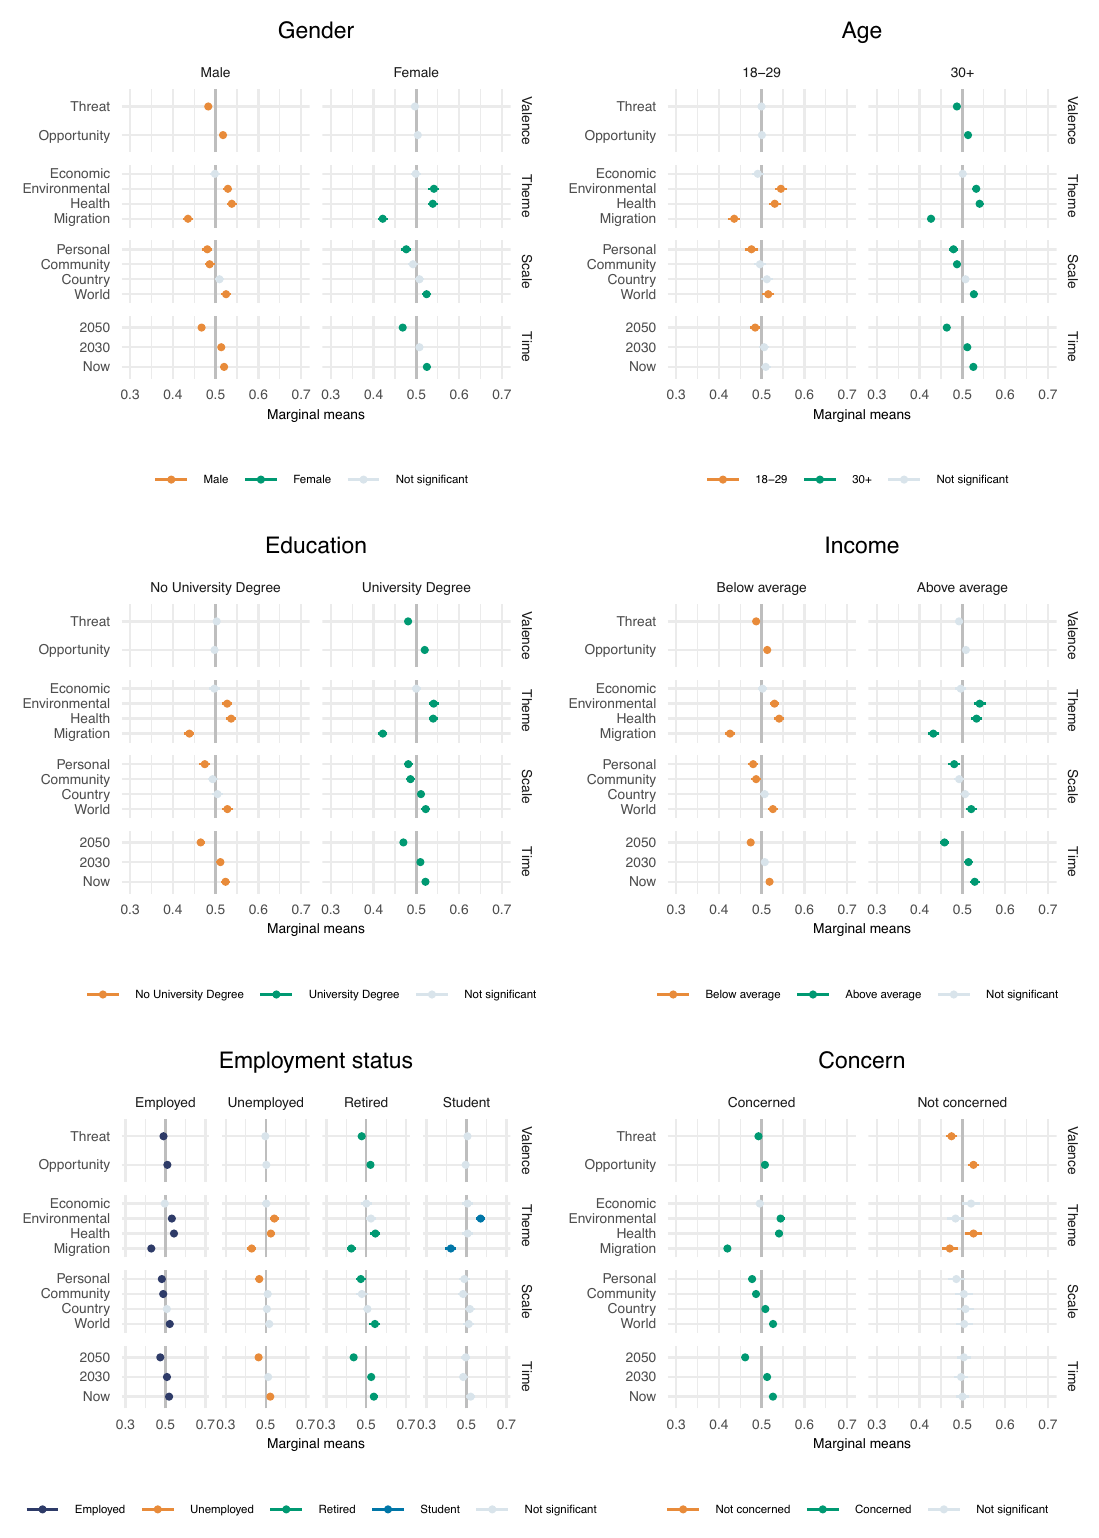
Fig. 2 Pooled results of the effects of different climate frames on support for climate policies across subgroups of respondents. Sample size n = 7512. Data are weighted to be nationally representative. Fieldwork by Deltapoll, October 2020. Question: Respondents were shown two statements in which the valence, theme, scale, and time frame were varied at random, providing 96 possible permutations. Respondents were asked: Indicate which of the two statements would make you more likely to support policies to tackle climate change. Dots with horizontal lines indicate marginal means with 95% con fi dence intervals